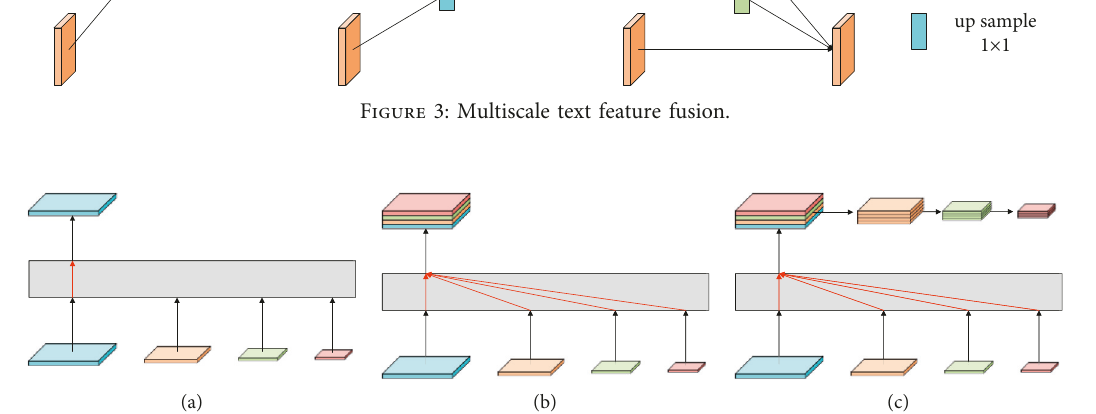
Figure 4: The last layer of the text feature extraction method.